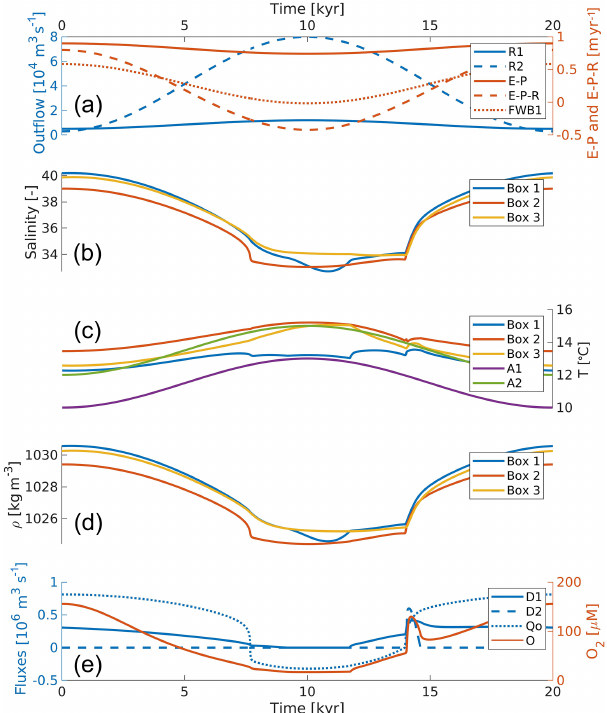
Figure 6. The forcing and results of the run in which the freshwater budget of the whole basin becomes positive for a brief period. The layout of the panels is the same as in Fig.